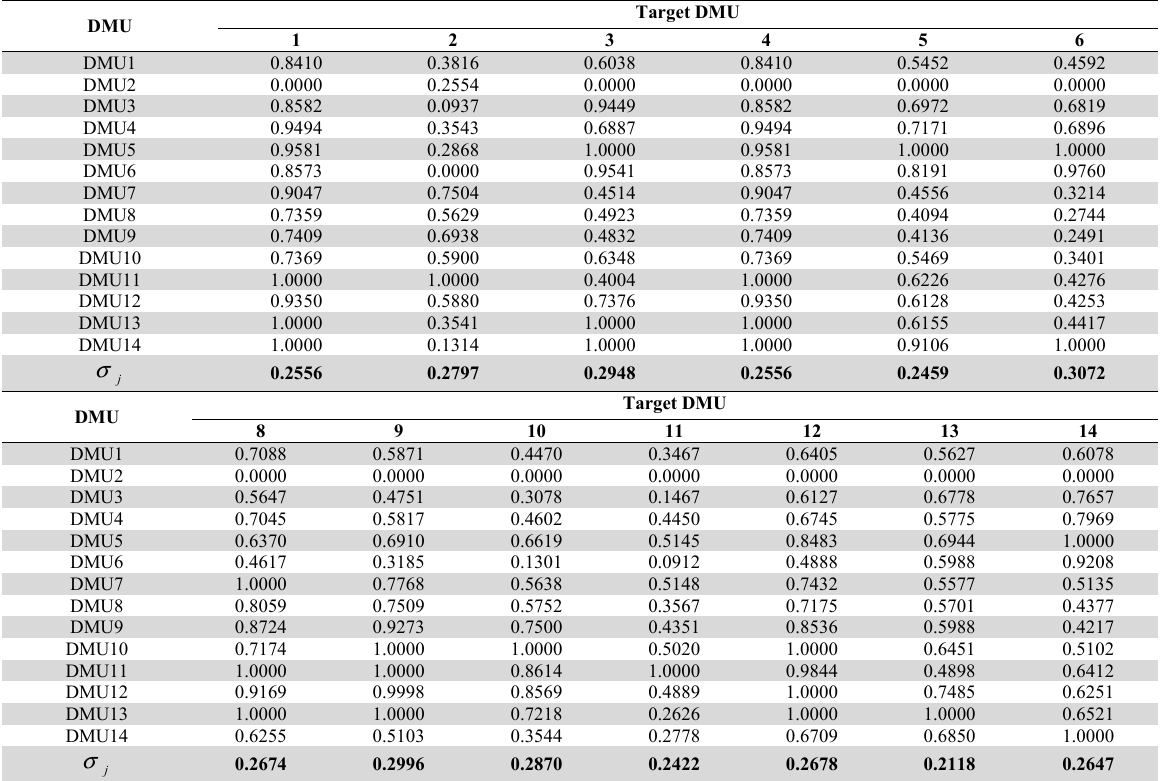
Normalized CEM of fourteen international passenger